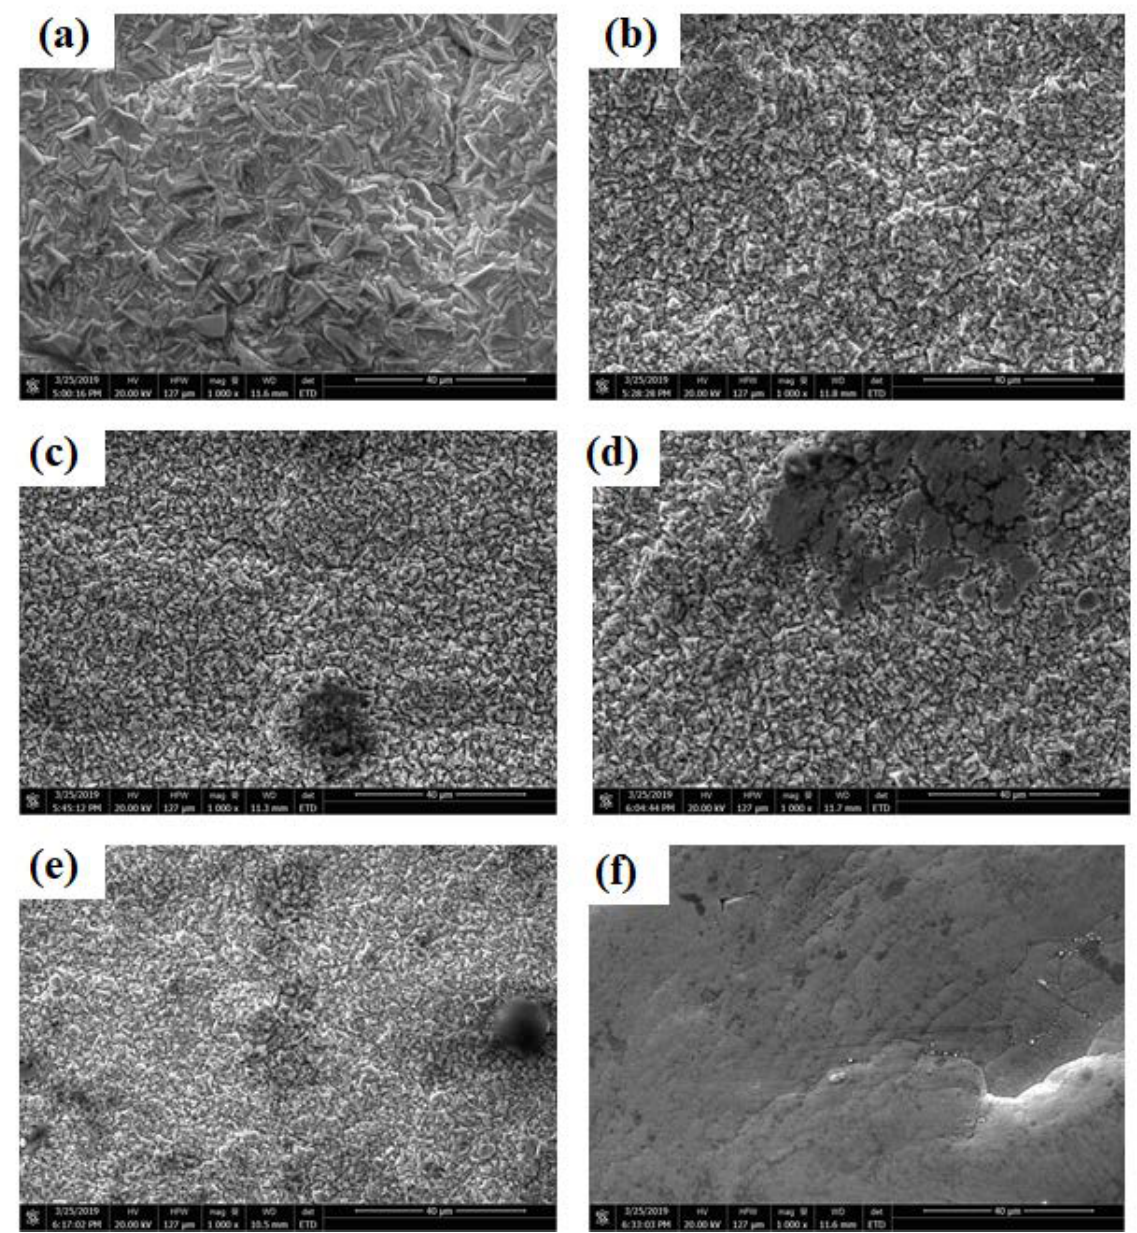
Figure 3. SEM images ( a ) Zn ( b ) Zn-Ni-10 ( c ) Zn-Ni-15 ( d ) Zn-Ni-20 ( e ) Zn-Ni-25 ( f ) Ni coatings .